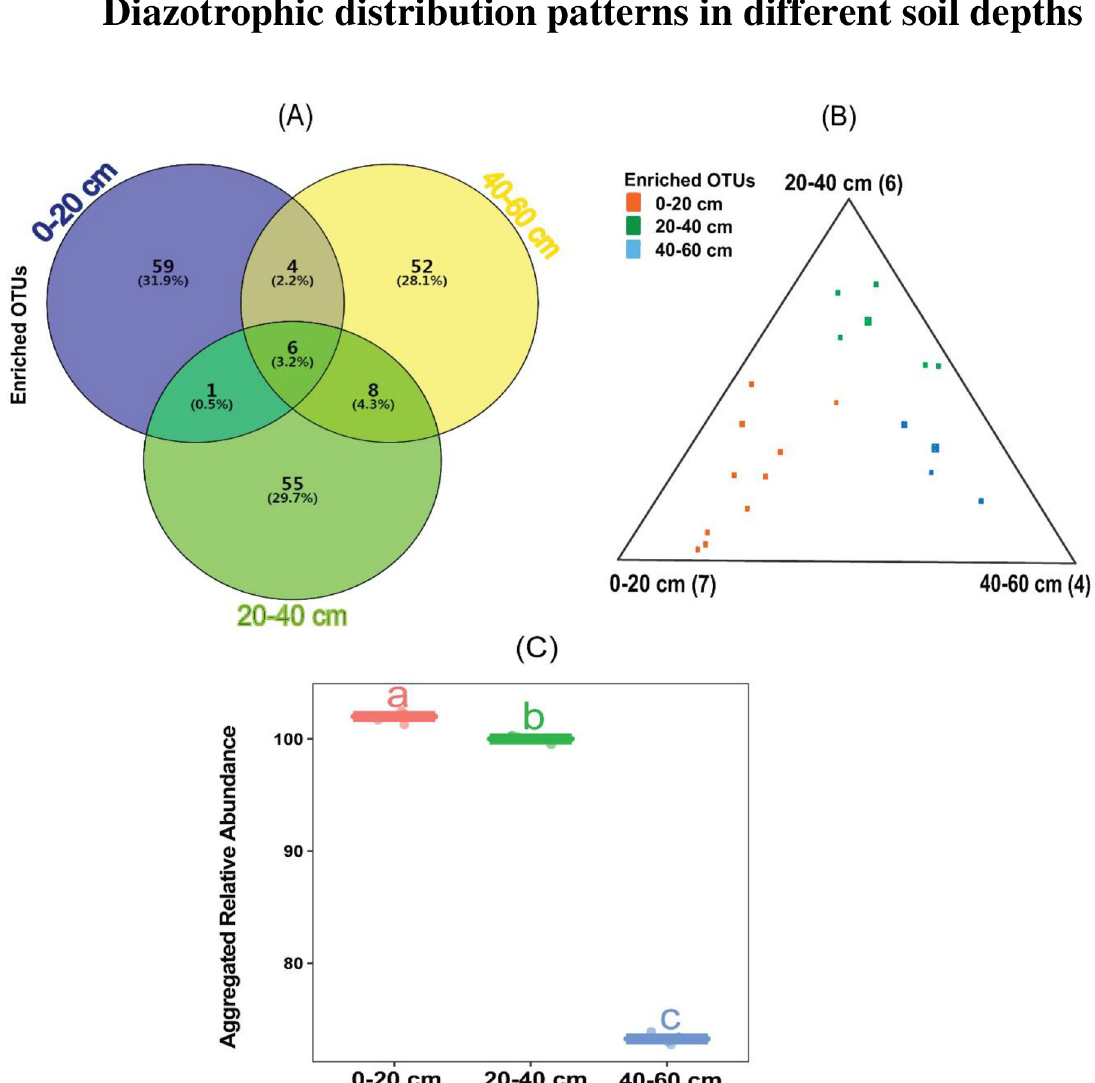
Fig 7. Diazotrophic genera enriched OTUs distribution patterns in different soil depths, A-C. A, Percentage of enriched diazotrophic OTUs in different soil profiles. B, Ternary plot depicting compartment specificity relative abundance of all enriched OTUs ( > 5%) for diazotrophic distribution patterns in different soil depths. Each point corresponds with an OTU. Its position represents its relative abundance with regard to each compartment, and its size represents the average across all three compartments. Colored circles represent diazotrophic OTUs enriched in one compartment compared with the others (0–20, 20–40 and 0–60 cm). C, Aggregated relative abundance of each group of enriched OTUs in three soil depths are shown. https://doi.org/10.1371/journal.pone.0253970.g007 Table 1. Multivariate ANOVA for the effects of soil depth, and different fertilizers on nifH OTUs, diversity, species richness, coverage and soil enzyme activities. OUT Shannon Chao1 Coverage Urease Cellulase Glucosidase Acid phosphatase Treatment NS NS NS NS NS NS NS NS Depth ��� �� ��� ��� ��� �� ��� ��� T X D ��� �� �� ��� ��� �� ��� ��� Depth stands for soil depth with 0–20 cm, 20–40 cm and 40–60 cm soil layers, treatment stands for fertilizer different fertilization with CK and BC.